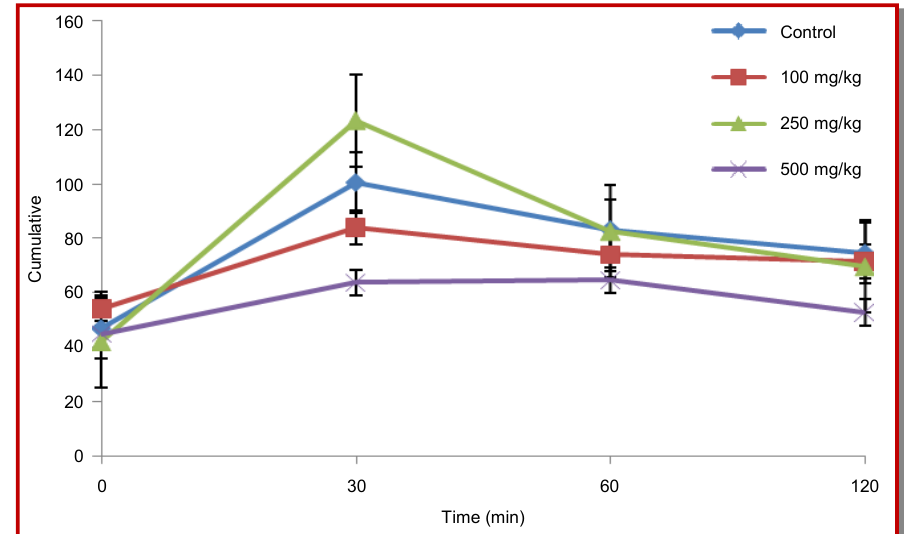
Figure 2: Oral glucose tolerance